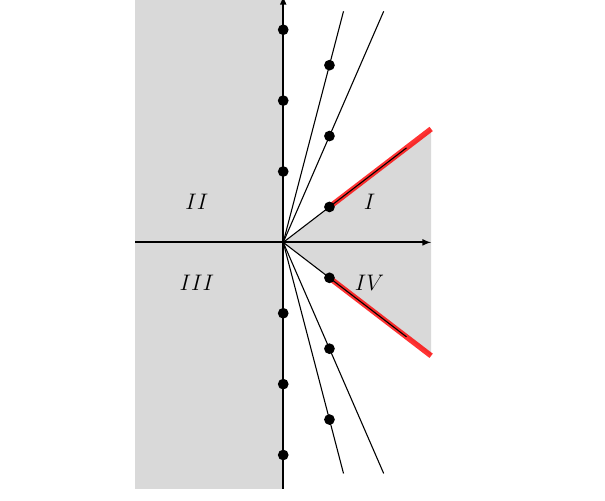
-plane for the series ϕ s